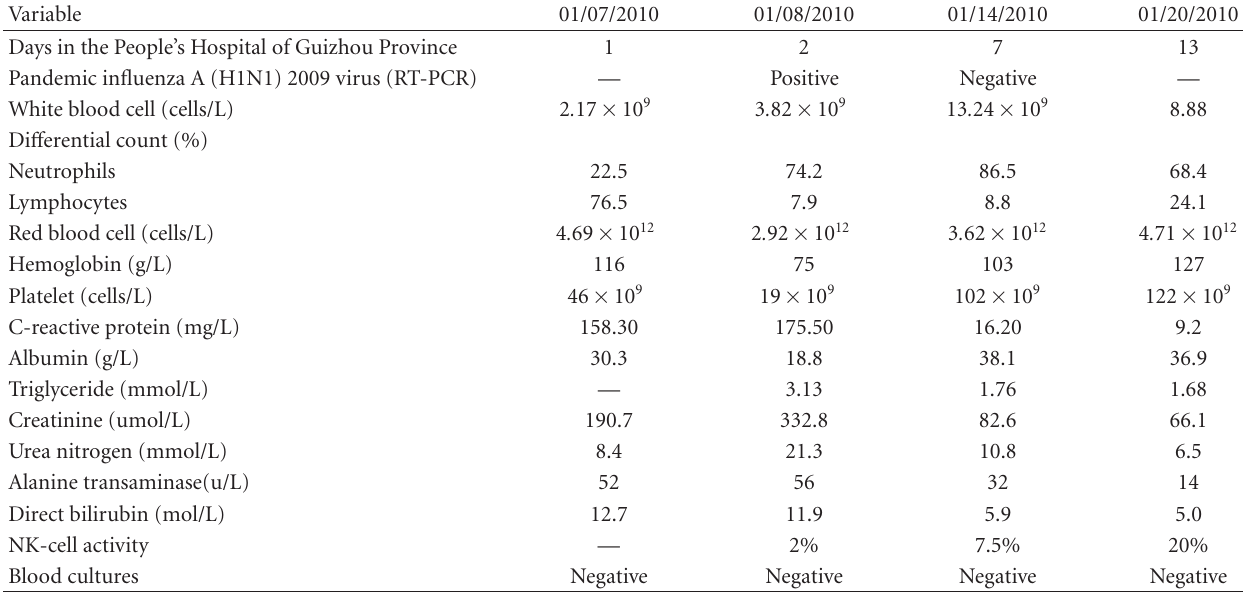
Table 1: Laboratory test results of the case on di ff erent days.